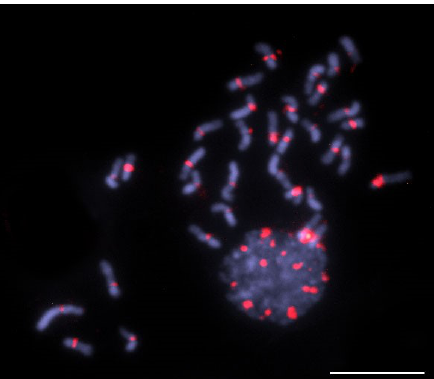
Figure 5. Chromosomal distribution of ThyaSat02-300 (red) detected by FISH in the chromosomes (blue) of T. hyalinata . Note that the signals for ThyaSat02-300 are much more restricted to the pericentromeric region in comparison to the signals observed for ThyaSat01-301 that occupy the whole extension of heterochromatin (Figure